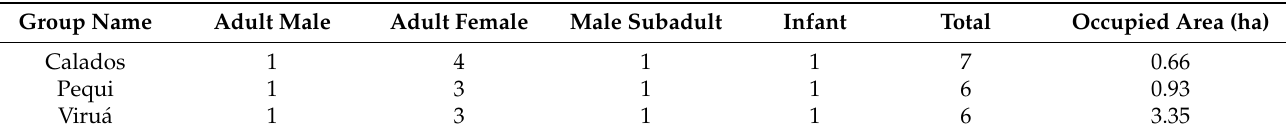
Table 1. Composition and size of occupied areas for the three groups of Guianan red howler monkeys monitored in Viruá National Park, Brazil. Infants were of unknown sex and were identified because they were still riding on female backs. Subadults were identified by their smaller size than fully developed adults.